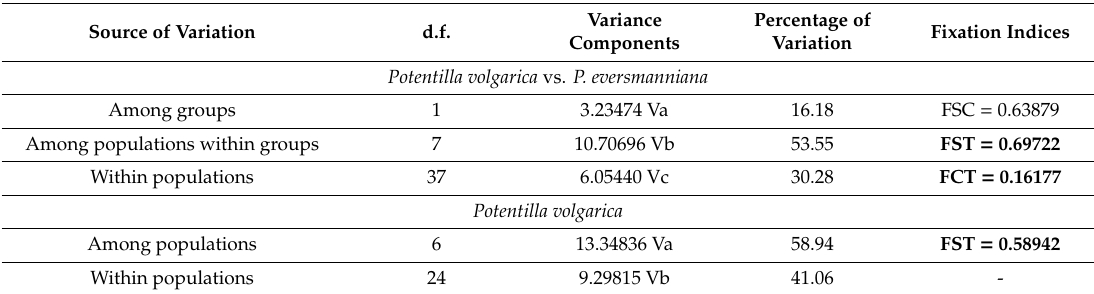
Table 1. AMOVA results for Potentilla volgarica and P. eversmanniana based on plastid DNA sequences. Fixation indices significant at p < 0.05 are highlighted in bold.